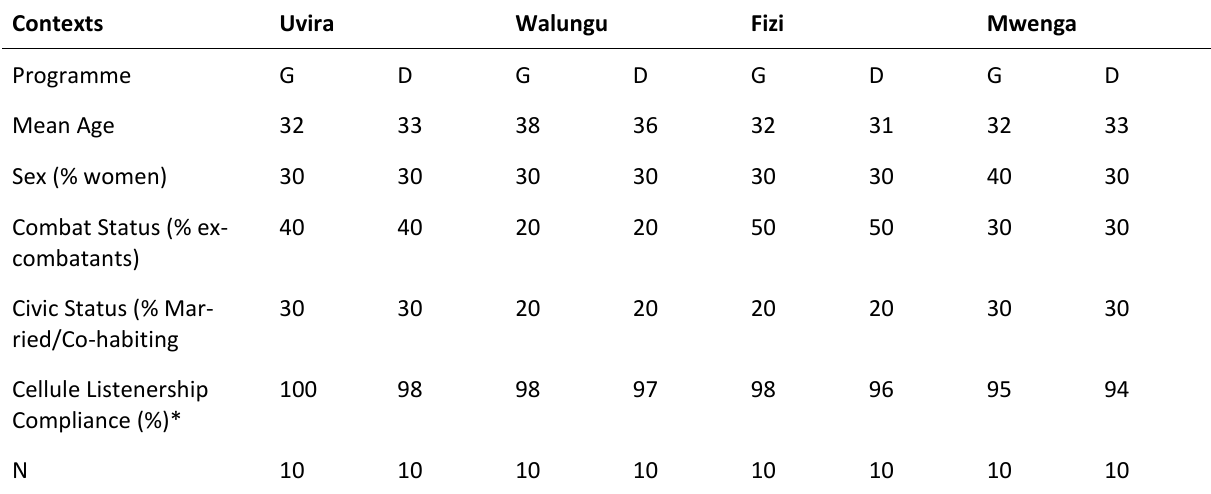
Table 1. Demography of Hutu ethnic network Focus Group discussants.